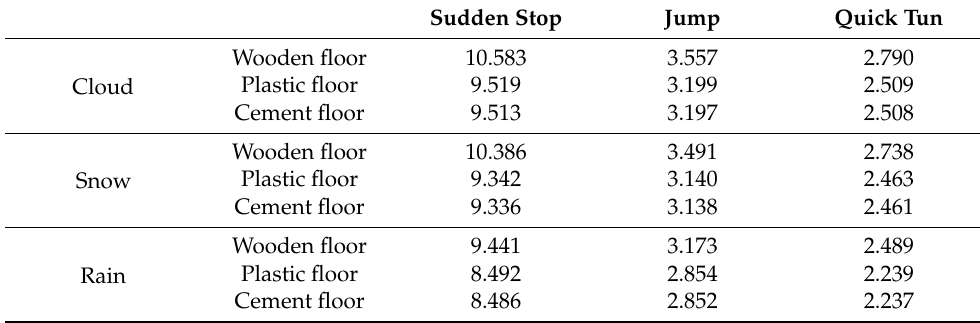
Table 9. Odd ratio (OR) value of combined risk factors (contact